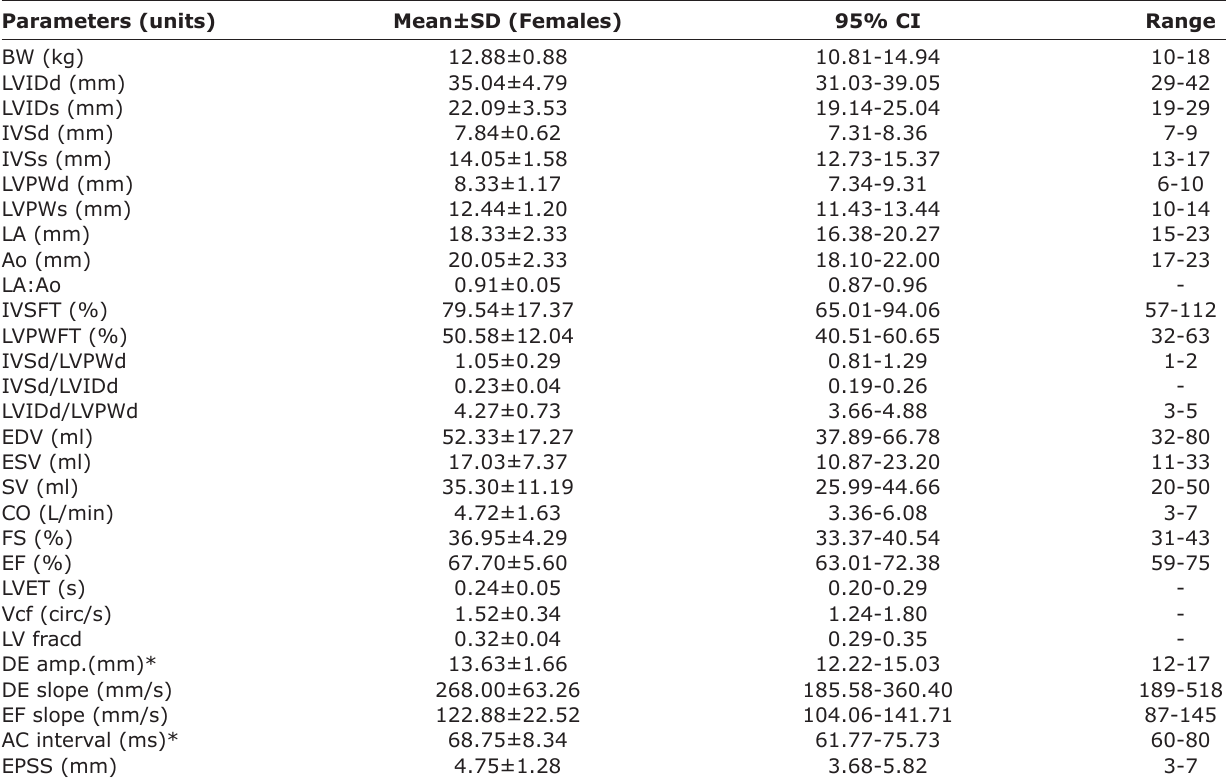
Table-3: M-mode echocardiographic measurements in female Indian Spitz dogs. Parameters